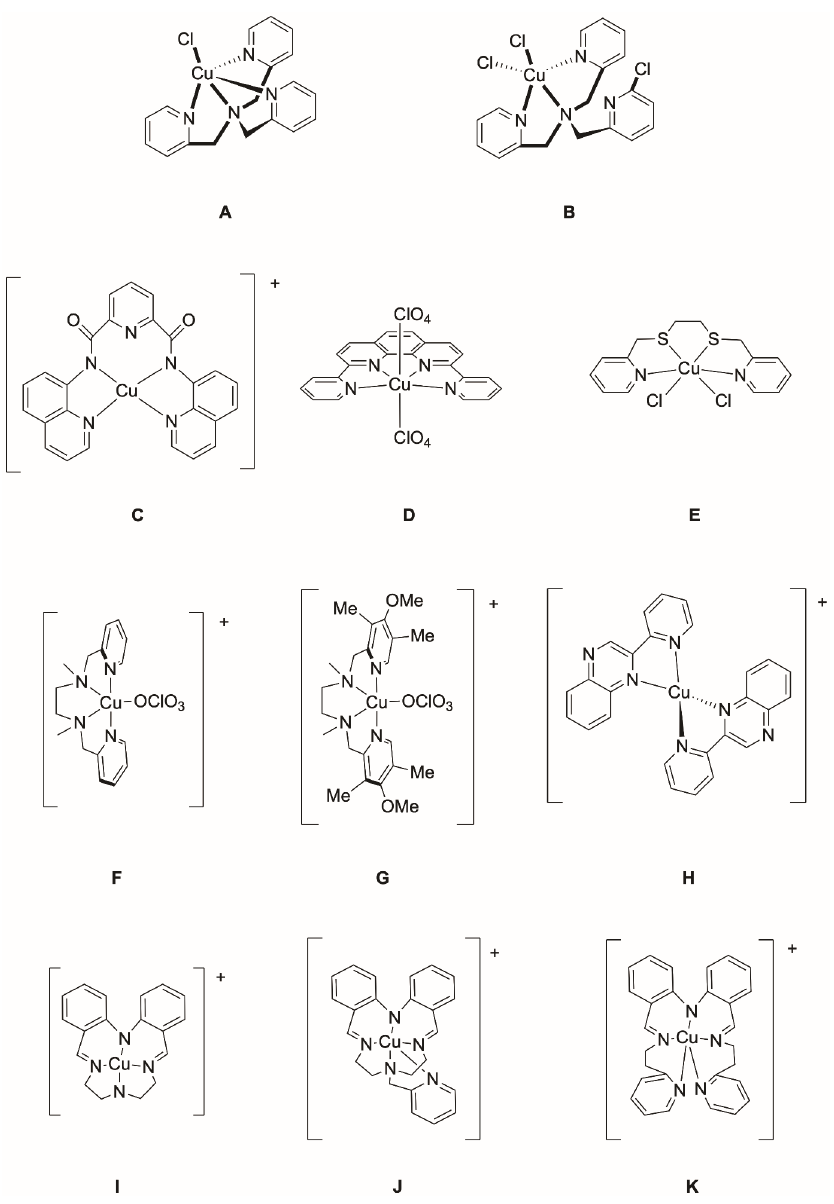
Figure 1. Chemical structures of copper complexes used for photocatalytic H 2 production.